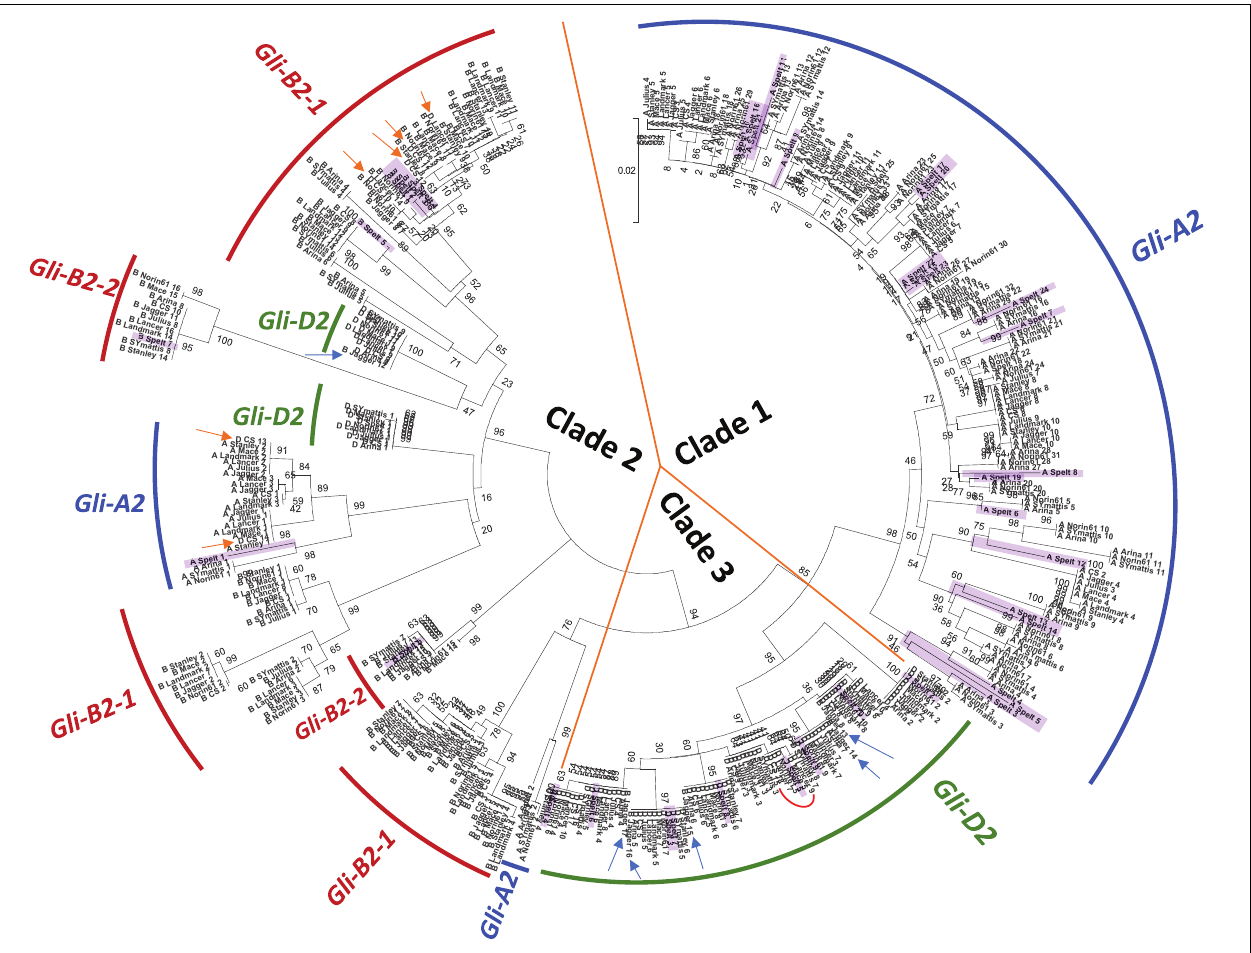
FIGURE 1 | Phylogenetic relationship of α -gliadin copies in 11 wheat accessions, including spelt. The 429 α -gliadin copies showed clustering based on subgenome assignment. The evolutionary tree is largely divided into three clades. Each subclade is indicated by the arcs and colored according to the corresponding Gli-2 loci. Numbers at branch splits are bootstrap percentages. Copies assigned to loci to which they do not cluster are indicated by arrows: Gli-B2-3 in Jagger are in blue, and Gli-D2 in CS and LongReach Lancer are in orange. Spelt copies are highlighted in light purple. The red curve in clade 3 highlights the seven sequences containing the immunotoxic